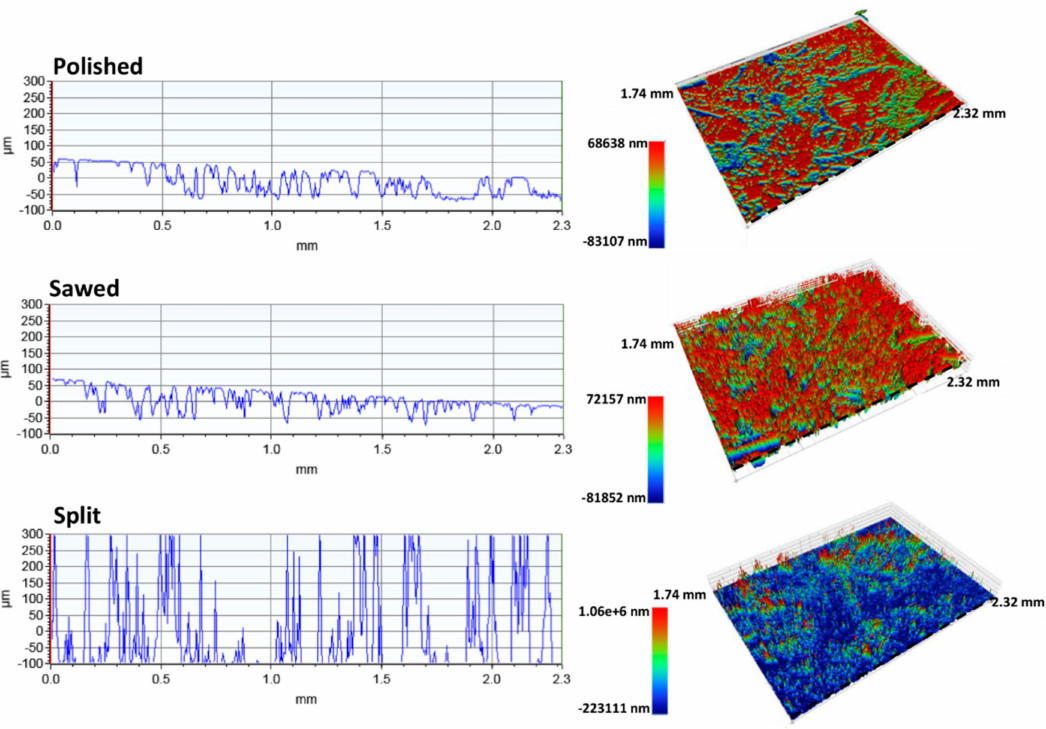
Figure 10. Surface roughness profiles and corresponding 3D models of the polished, sawed, and split surfaces of the Gabbro. Note that the 3D models have different topographic scales. Dashed line indicates location of the topographic